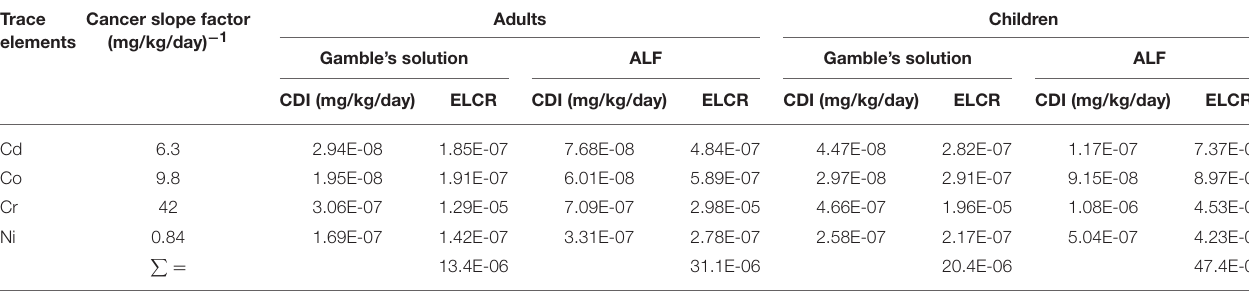
TABLE 3 | Excess life time cancer risk (ELCR) estimated for adults and children. Trace Cancer slope factor elements (mg/kg/day) − 1